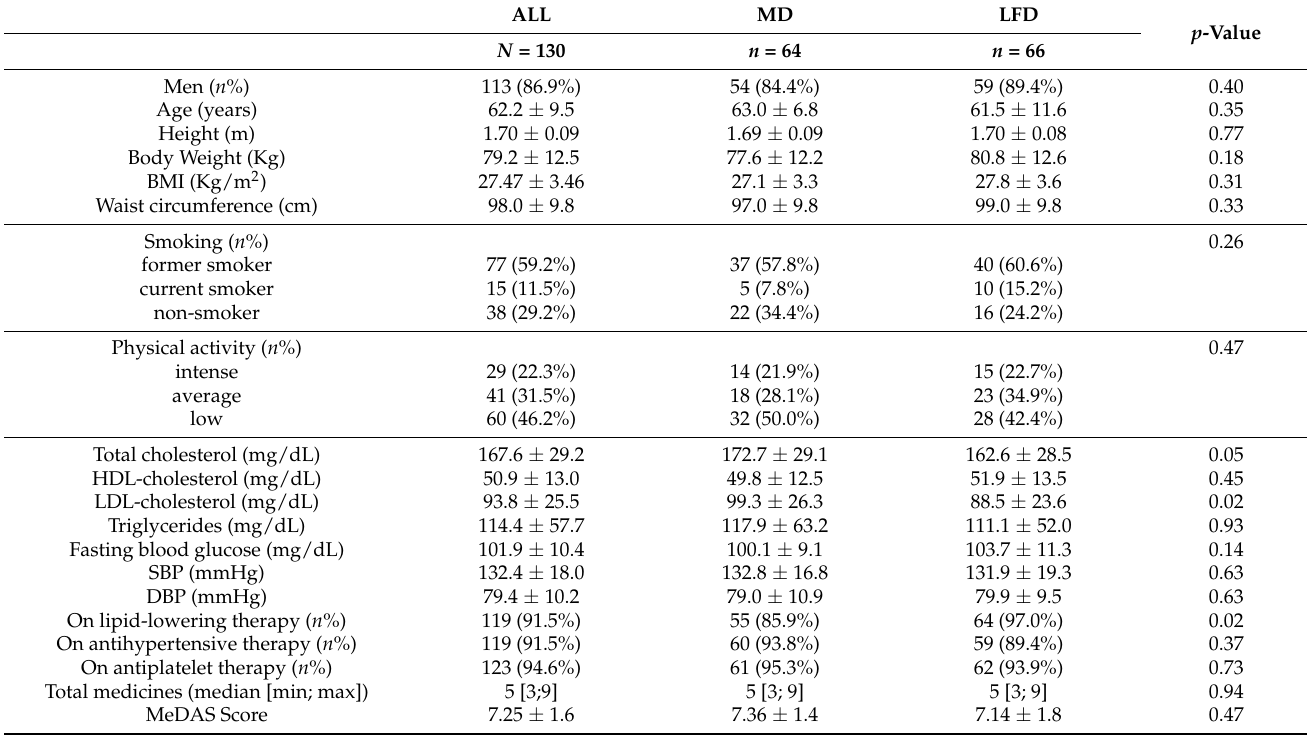
Table 1. Baseline population